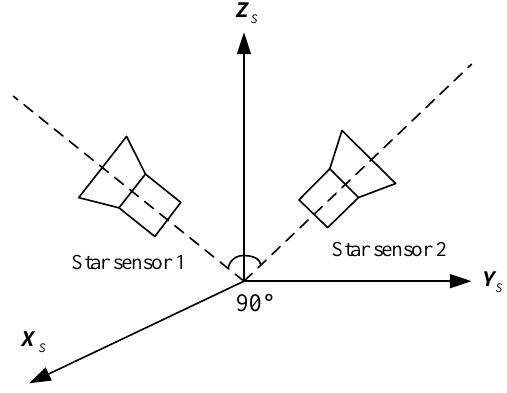
Figure 4. Installation configurations of double star sensors.